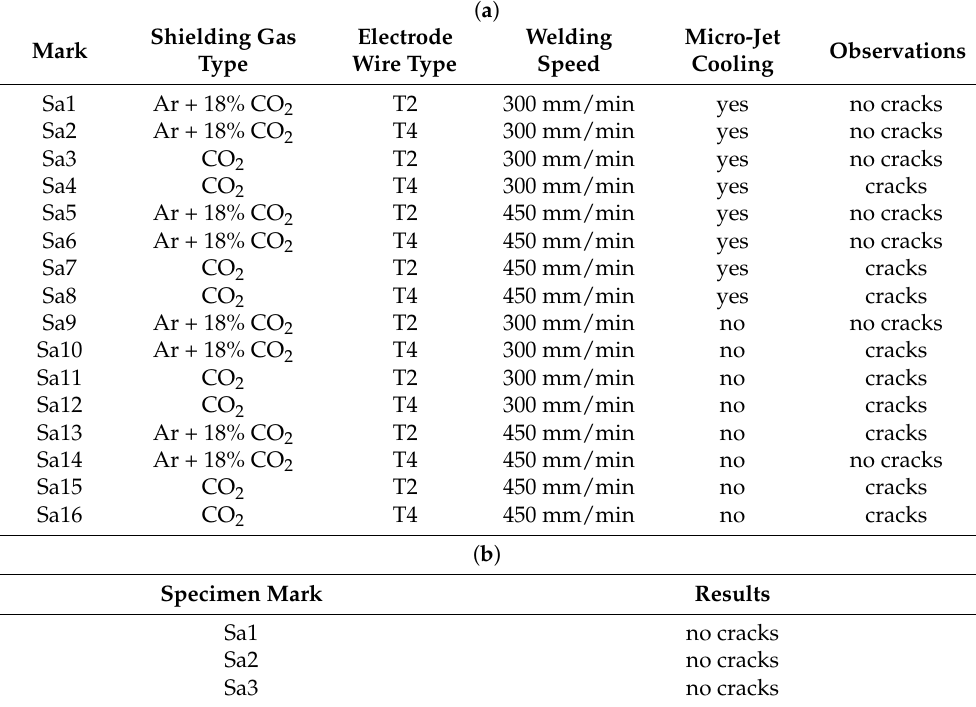
Table 4. ( a ) The NDT test results of welded joints. ( b ) The results of the static bending test of joints with respect to